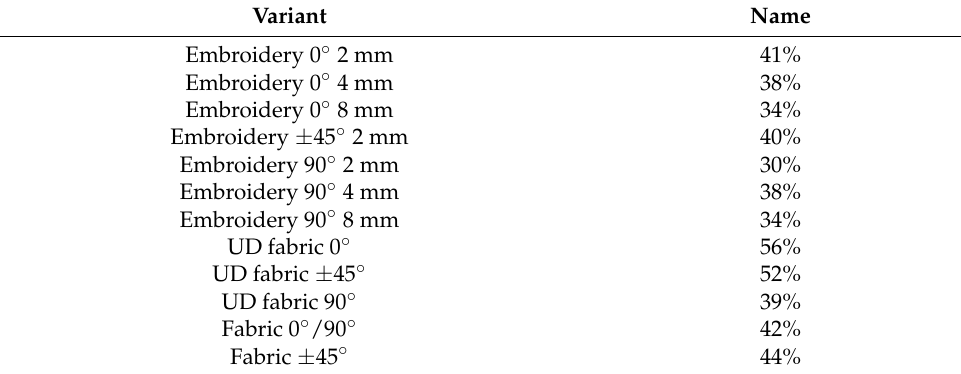
Table 2. The volume fraction of produced composites.